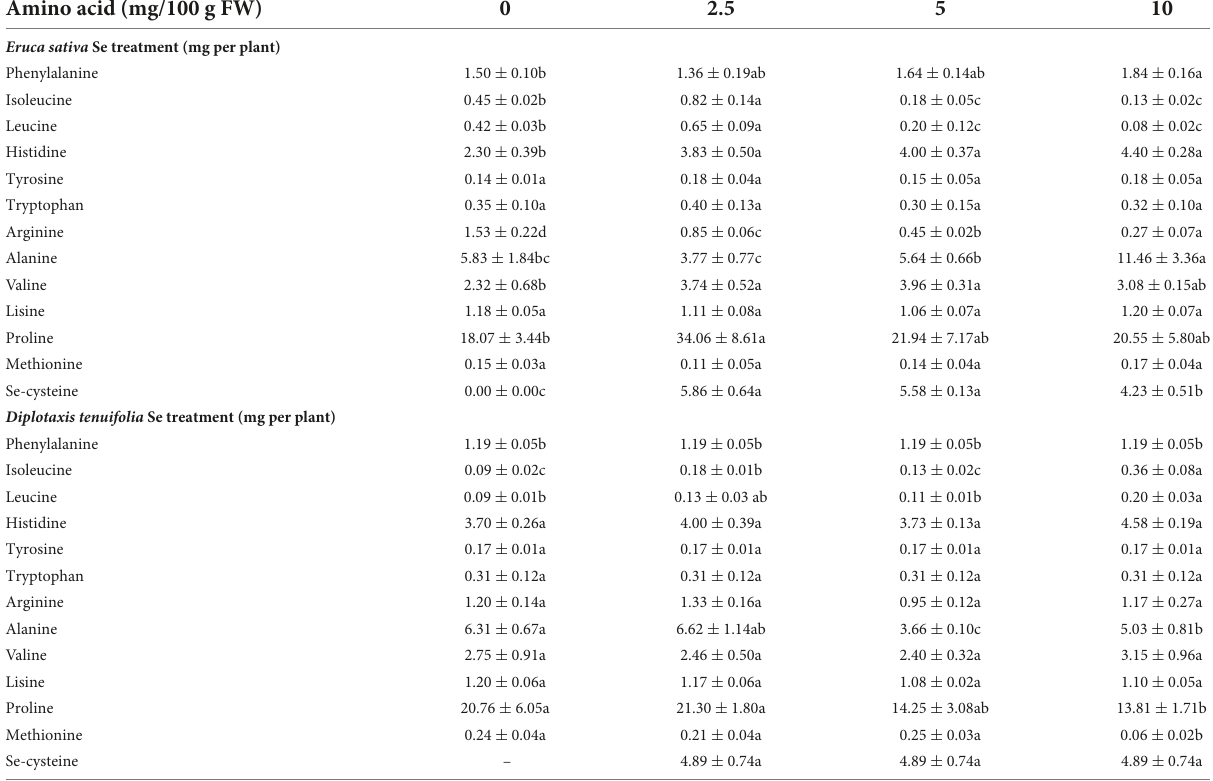
TABLE 1 Effects of selenate treatment on the content of selected amino acids in leaves of rocket species ( Eruca sativa and Diplotaxis tenuifolia ) grown in soil and treated foliarly with selenate dosages ranging from 0 to 10 mg per plant. Amino acid (mg/100 g